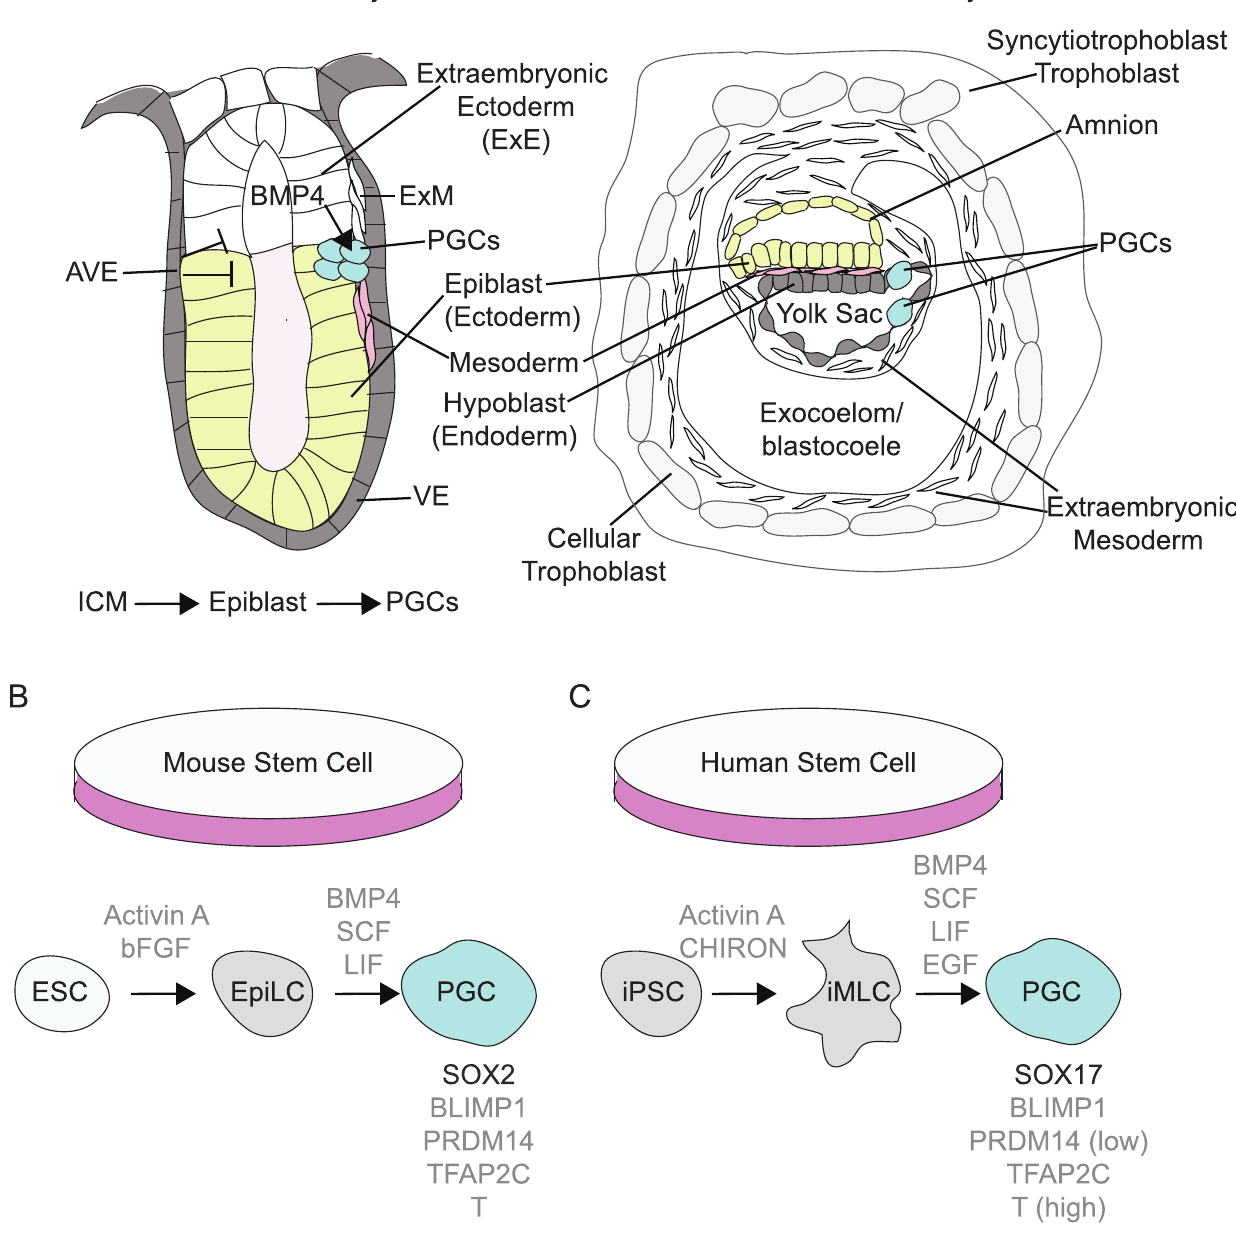
Figure 3. Primordial germ cell (PGC) induction in mammals. ( A ) The early stages of PGC emergence in mouse and humans. In mouse, cues from extra-embryonic ectoderm, including bone morphogentic proteins (BMPs), induce transcriptional regulators that promote PGC identity in the cells of the adjacent posterior epiblast. In humans, PGCs are first detected around the onset of gastrulation within the endodermal yolk sac wall. The signals that induce human PGCs in vivo are not known. ( B , C ) The molecular players involved in PGC specification from stem cells in culture. ( B ) For mouse cells, the program to induce primordial germ cell-like cells (PGCLCs) from embryonic stem cells (ESCs) in culture requires transforming growth factor-beta (TGF- β ) family members (Activin) and basic fibroblast growth factors (bFGFs) to promote an epiblast-like cell (EpiLC) state. Exposure of the EpiLCs to BMPs (BMP4) and stem cell factor (SCF) and leukemia inhibitory factor (LIF) converts the EpiLCs to cells with mouse PGC-specific gene expression profiles. ( C ) For human cells, the program to induce PGCLCs from human-induced pluripotency cells (iPSCs) in culture like mouse requires TGF- β family members (Activin) and CHIRON to inhibit glycogen synthase kinase 3, an inhibitor of Wnt activity. This combination of factors promotes an induced mesoderm-like cell (iMLC) fate, which upon exposure to BMP4, LIF, SCF, plus epidermal growth factor (EGF) generates cells with human PGC-specific gene expression profiles. Notably, the transcription factor Sox2 is required in mouse cells, whereas Sox17 is necessary for human cells. In addition, PRDM14 is highly expressed in mouse PGCs and has been reported to be low or not expressed in human PGCs. AVE, anterior visceral endoderm; ExM, extra-embryonic mesoderm; ICM, inner cell mass; VE, visceral